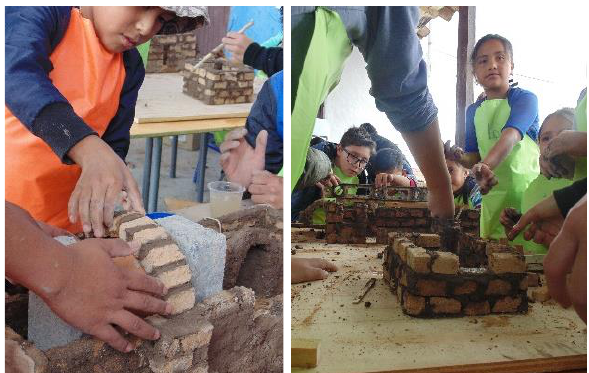
Figure 2. c) construction of the chapel arch, d) construction of